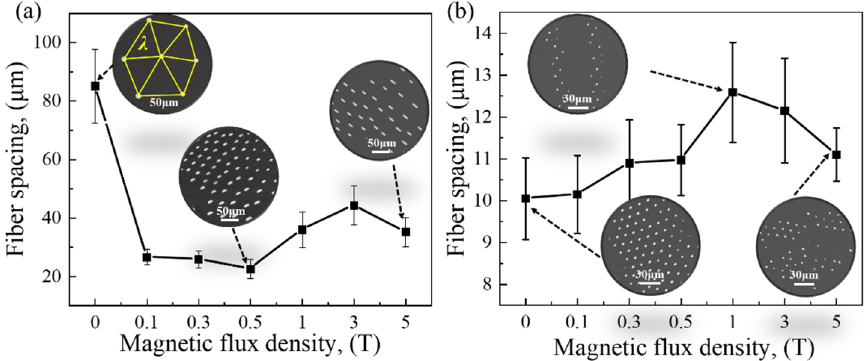
Figure 3. The fiber spacings ( λ ) on the transverse sections of ingots directionally solidified under various MFDs at growth rates of 1 µ m/s ( a ) and 5 µ m/s ( b ),